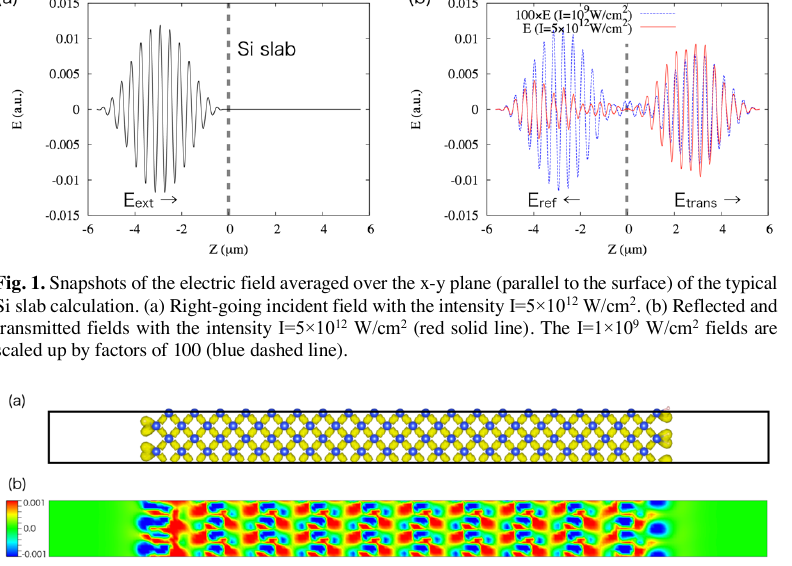
Fig. 2. (a) Structure and static electron density of the Si slab of Fig. 1. (b) Density difference with the static density at T= ８ fs by slicing in the [1,-1,0]